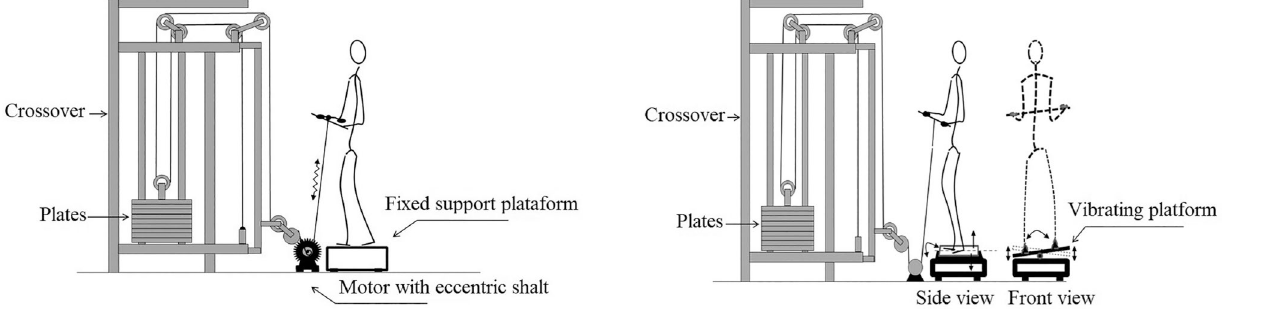
Figure 1 - Motor positioning for localized location application. Figure 2 - Platform positioning for whole-body vibration